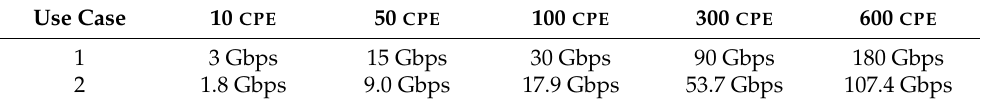
Table 6. Total user data rate requirement for two use cases as a function of number of CPE devices. Use